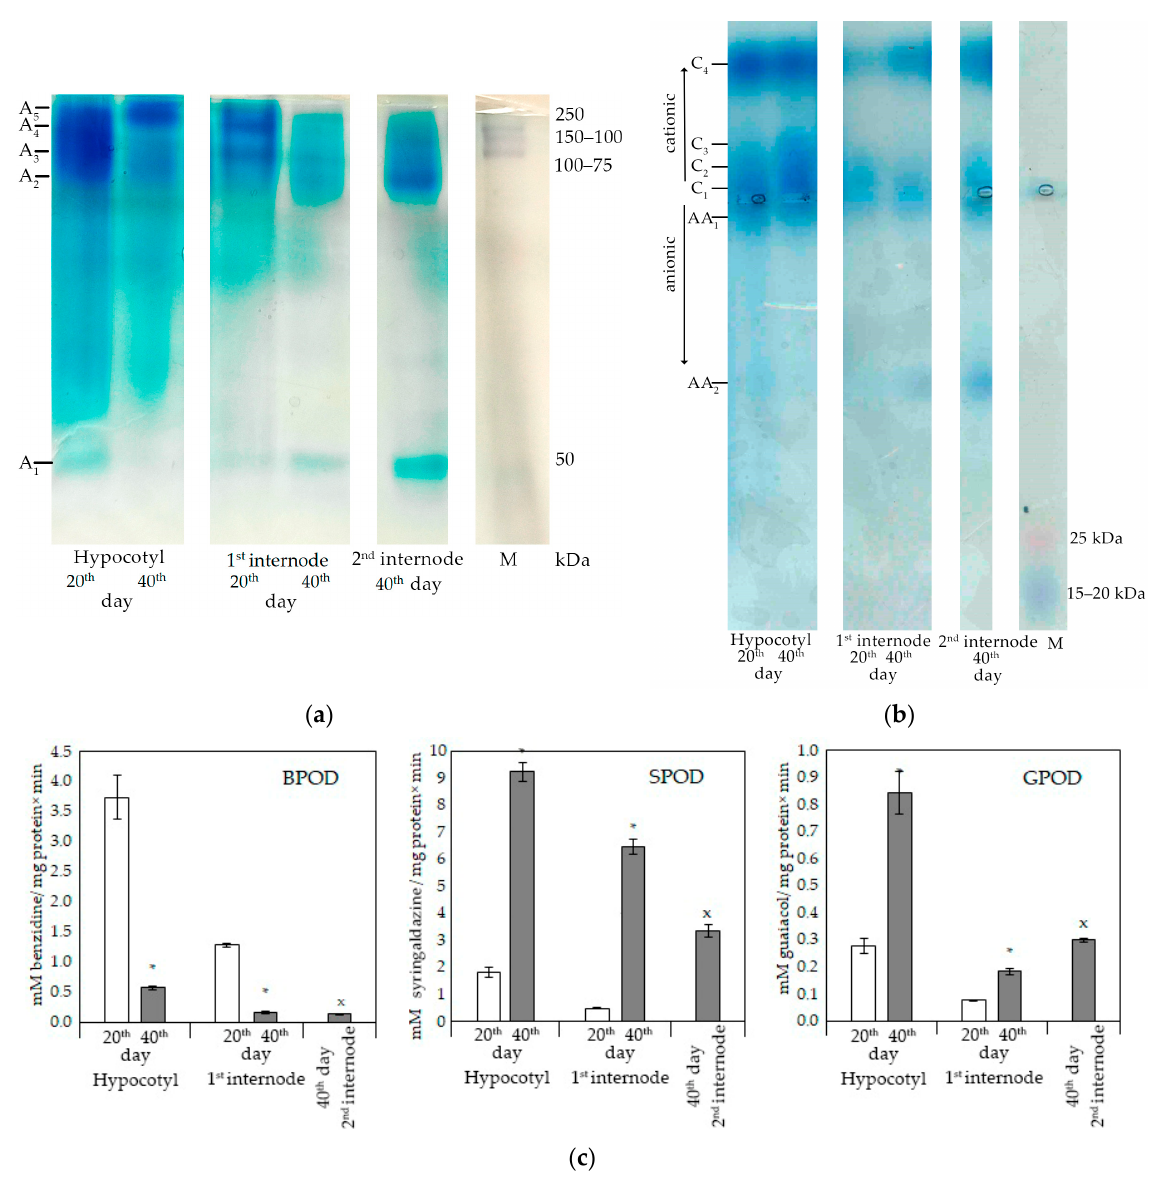
Figure 3. The spectrum of isoforms and the total activity of class III peroxidases in the hypocotyl and epicotyl of zinnia plants of different age: ( a ) anionic isoforms of peroxidases after their separation in PAAG; ( b ) cationic and anionic isoforms of class III peroxidases after separation in agarose; ( c ) enzymatic activity of BPOD, SPOD and GPOD ( n = 9). M is a molecular weight marker. Asterisks represent significant differences ( p < 0.05, U-test) between the 20th and 40th days. x represents significant differences ( p < 0.05, U-test) between the second and the first internode on the 20th day of zinnia growth.